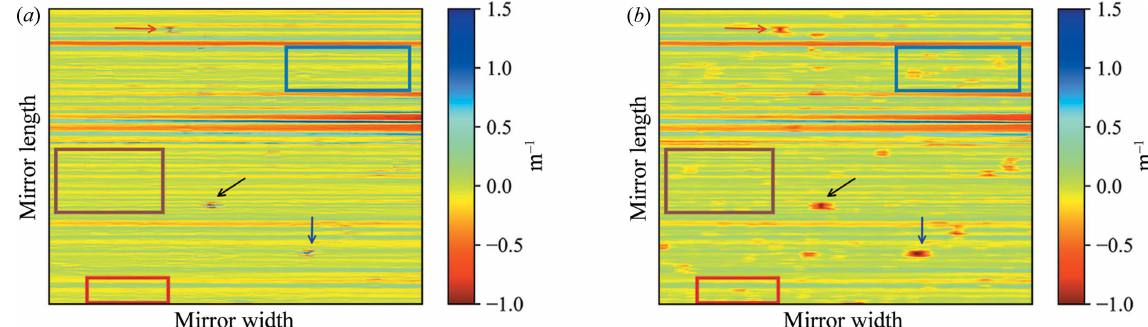
Figure 6 ( a ) The 2D map of the wavefront slope error measured using the differential-mode XSS technique was differentiated to produce a 2D map of the incident-beam-corrected wavefront curvature error shown here. ( b ) 2D map of the wavefront curvature error from the self-reference XSS technique for comparison. The errors derived from the incident beam wavefront can be easily observed in ( b ). The rectangular boxes demarcate areas in which artefacts in the wavefront of the incident beam are substantially reduced when using the differential-mode XSS technique. The arrows indicate strong artefacts that are not completely removed.